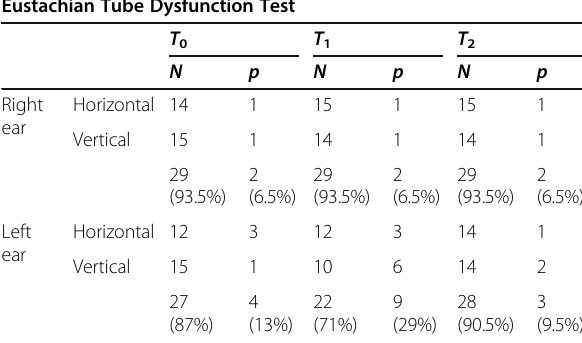
Table 4 The frequency of ETFE for the right and left ears according to the type of deformity and class of deformity during the time Eustachian Tube Dysfunction Test T